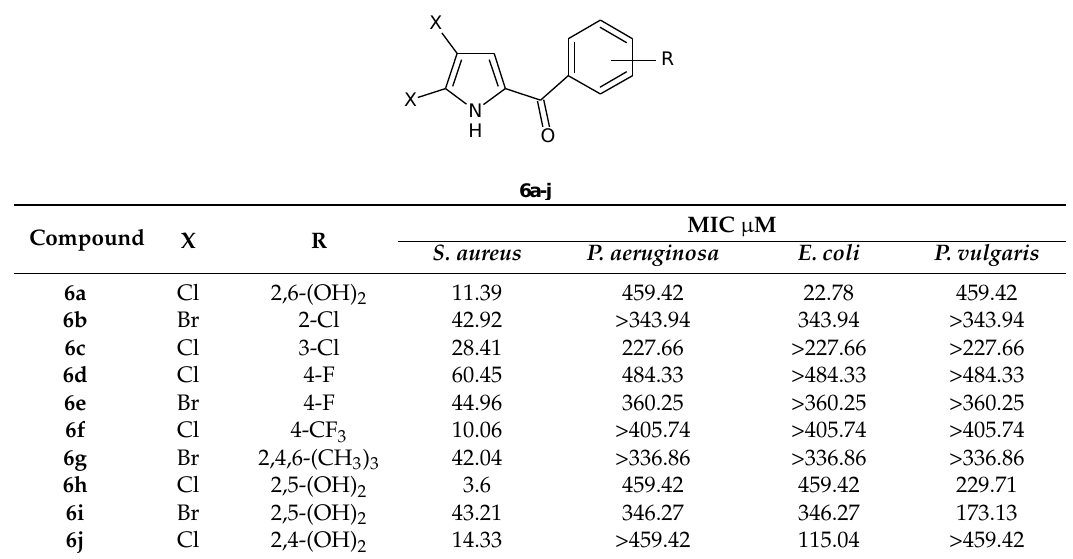
Table 5. In vitro antibacterial activity of compounds 6a – j